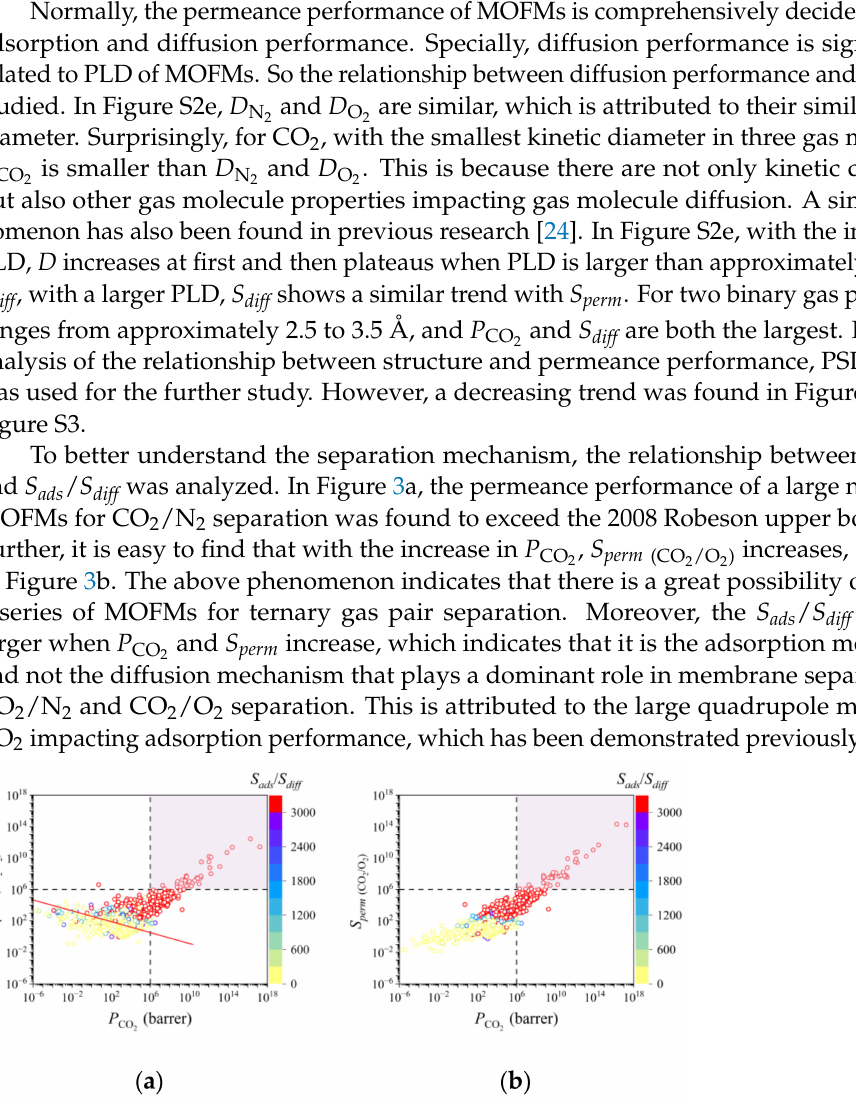
– S perm (CO – S ads (CO / S diff 2 2 /N 2 ) 2 /N 2 )